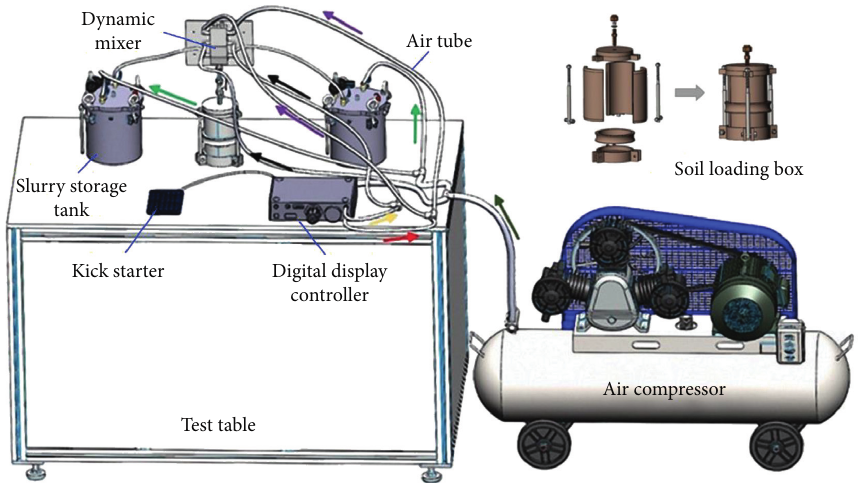
Figure 1: Fine grouting reinforcement test system for